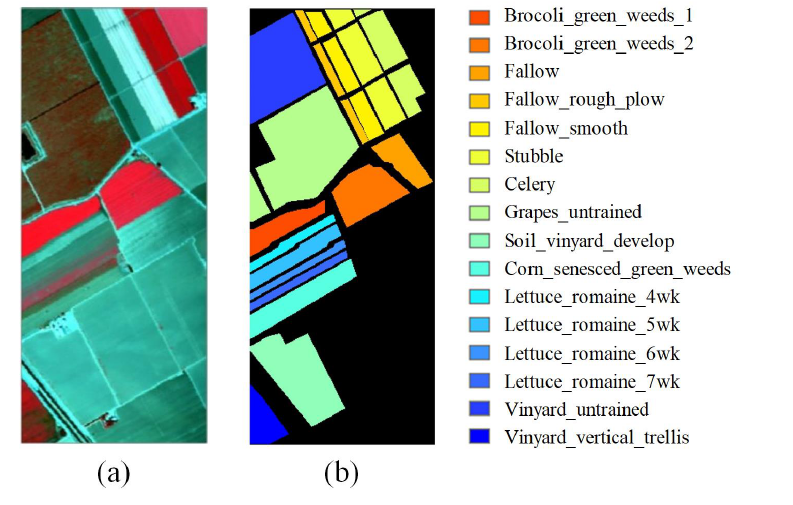
Figure 12. The Salinas scene: ( a ) false-color composite image; ( b ) ground